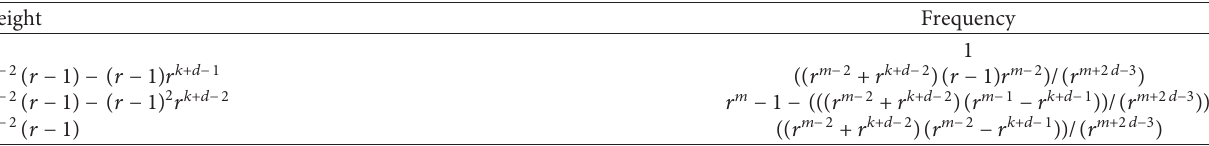
Table 10: Weight distribution of C